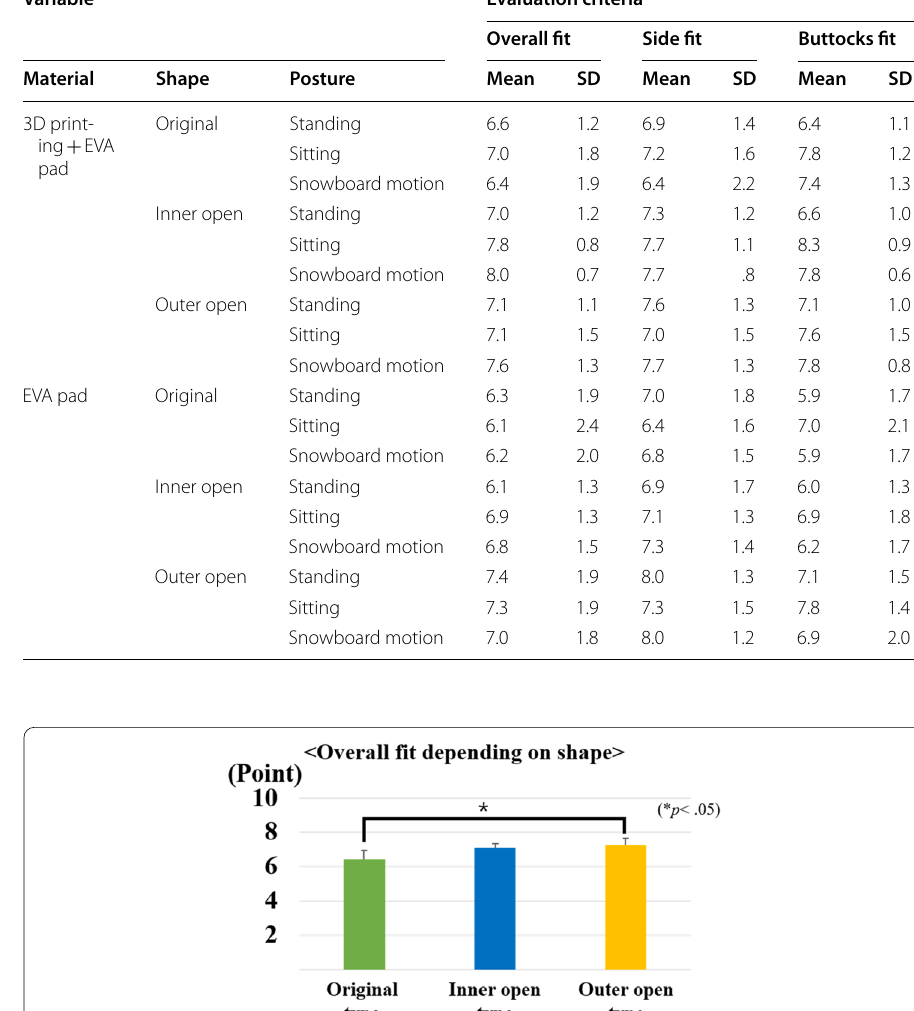
Table 5 Mean and SD of subjective fit evaluation depending on material, shape, and test posture (N 10) = Variable